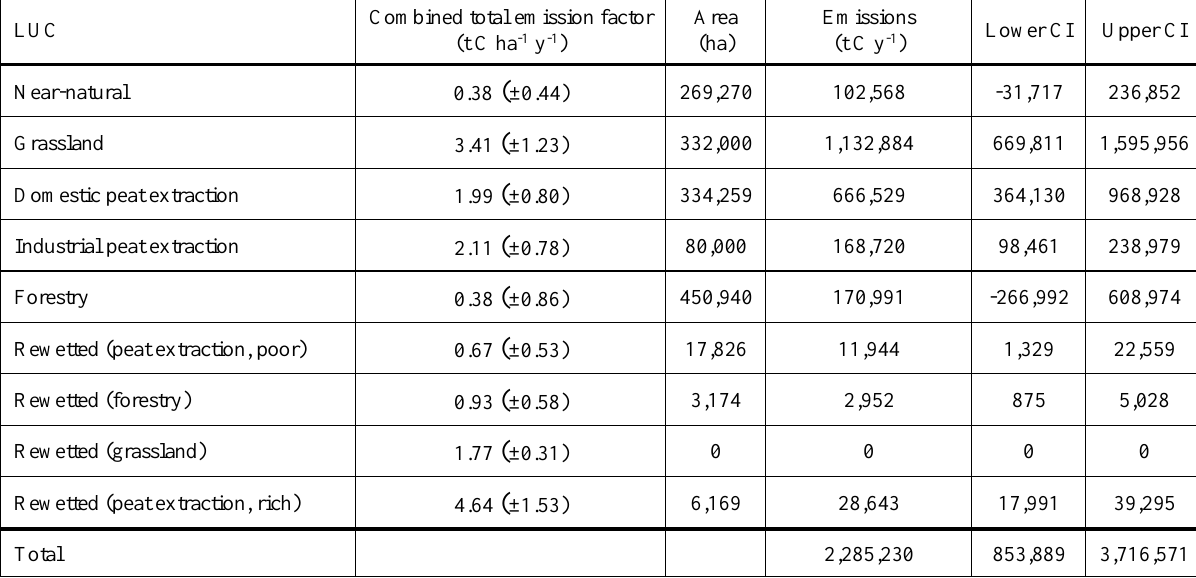
Table 4. Combined total carbon emission factor (t C ha -1 y -1 ), including carbon dioxide (CO and C fluvial losses EFs, as well as biomass sinks; area (ha), total emissions/removals (t C y -1 ) and uncertainty range (95 % Confidence intervals) from the main peatlands land use categories (LUC) in